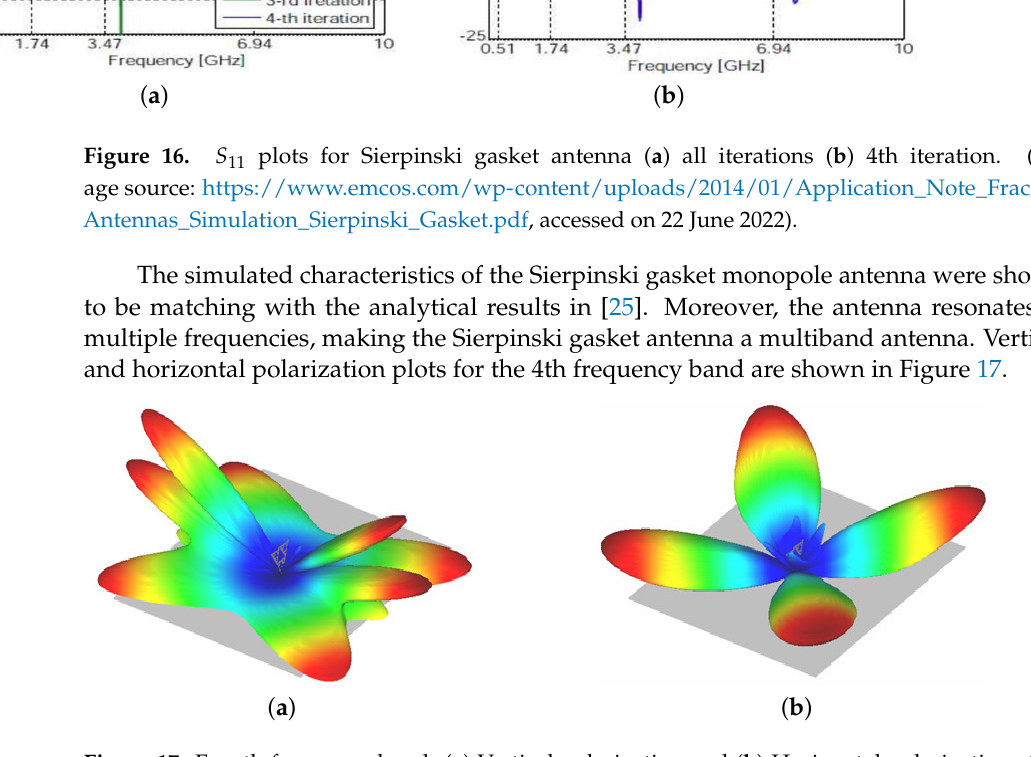
Figure 17. Fourth frequency band: ( a ) Vertical polarization and ( b ) Horizontal polarization. (Im- age source: https://www.emcos.com/wp-content/uploads/2014/01/Application_Note_Fractal_ Antennas_Simulation_Sierpinski_Gasket.pdf, accessed on 22 June